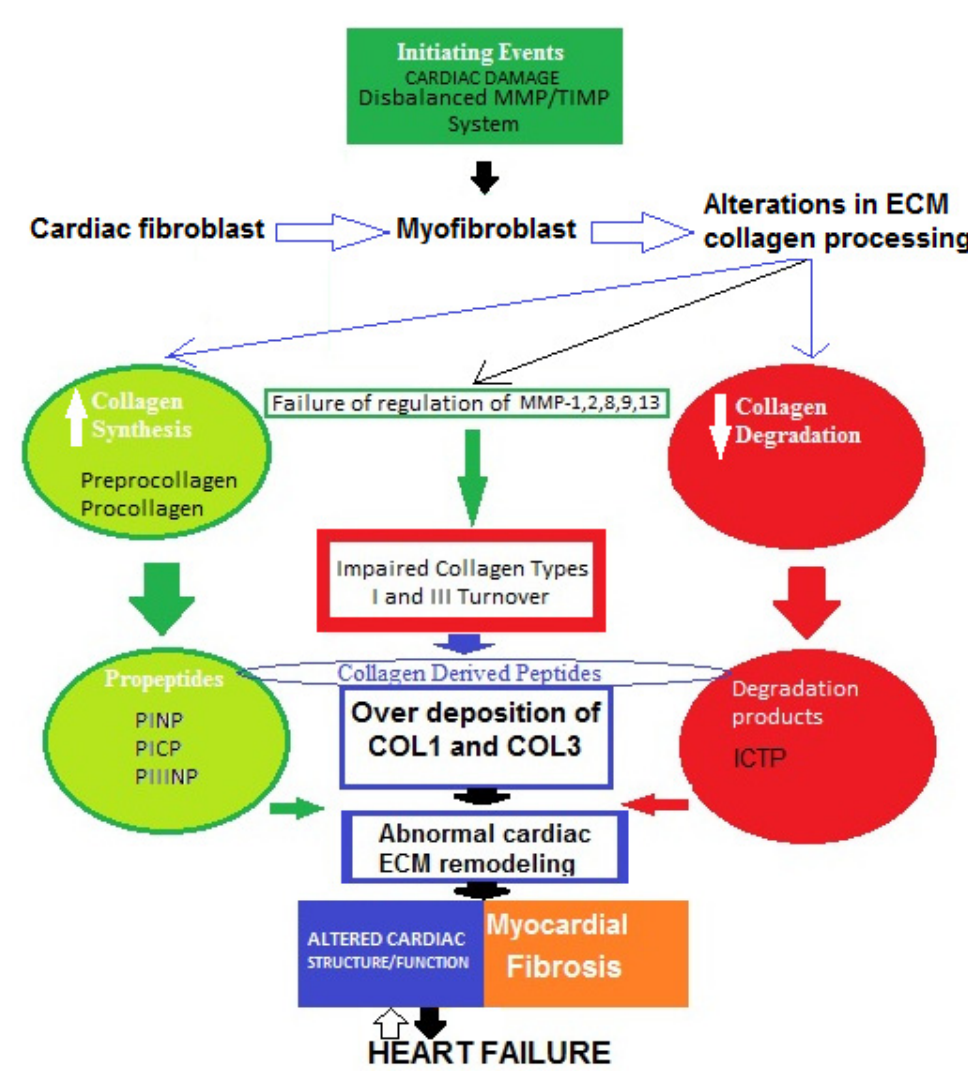
Figure 2. Possible schematic pattern illustrating eventual mechanisms of impaired collagen I and III turnover leading to myocardial fibrosis in heart